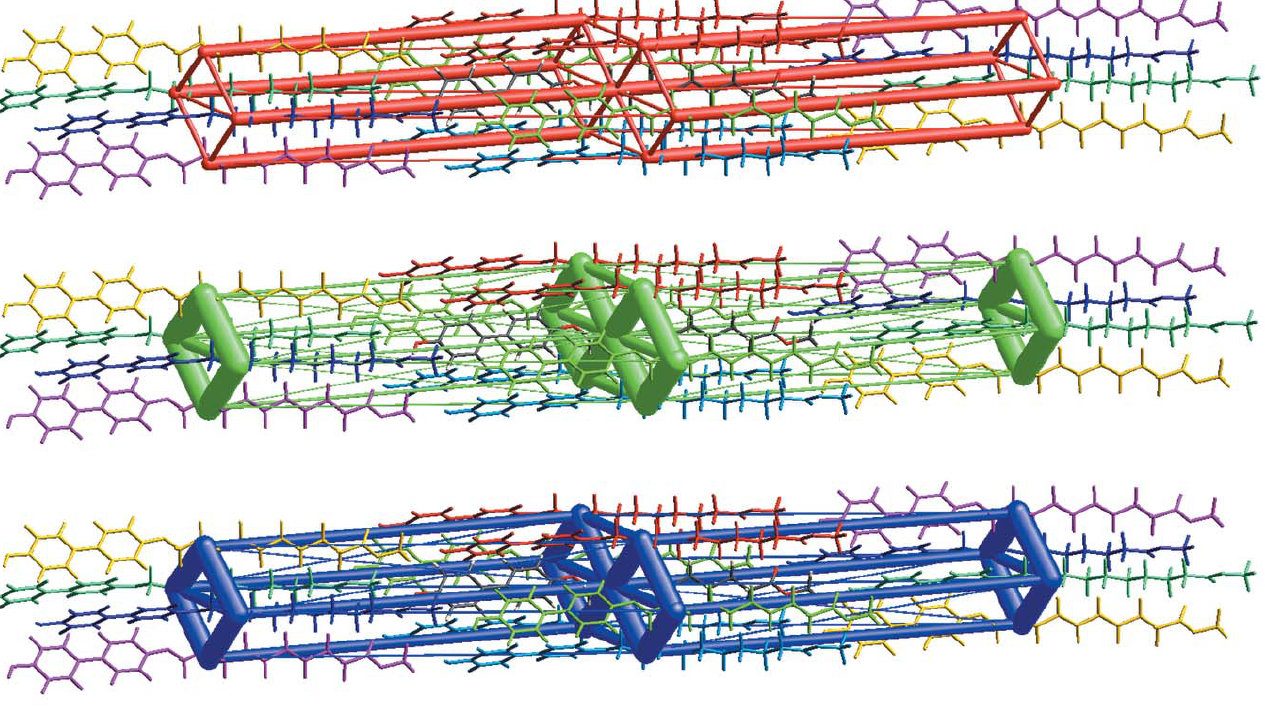
Figure 5 Energy framework diagram for separate electrostatic (top, red) and dispersion (middle, green) components of MBO10Me and the total interaction energy (bottom, blue). The energy factor scale is 120 and the cut-off is 5.00 kJ mol (cid:4) 1